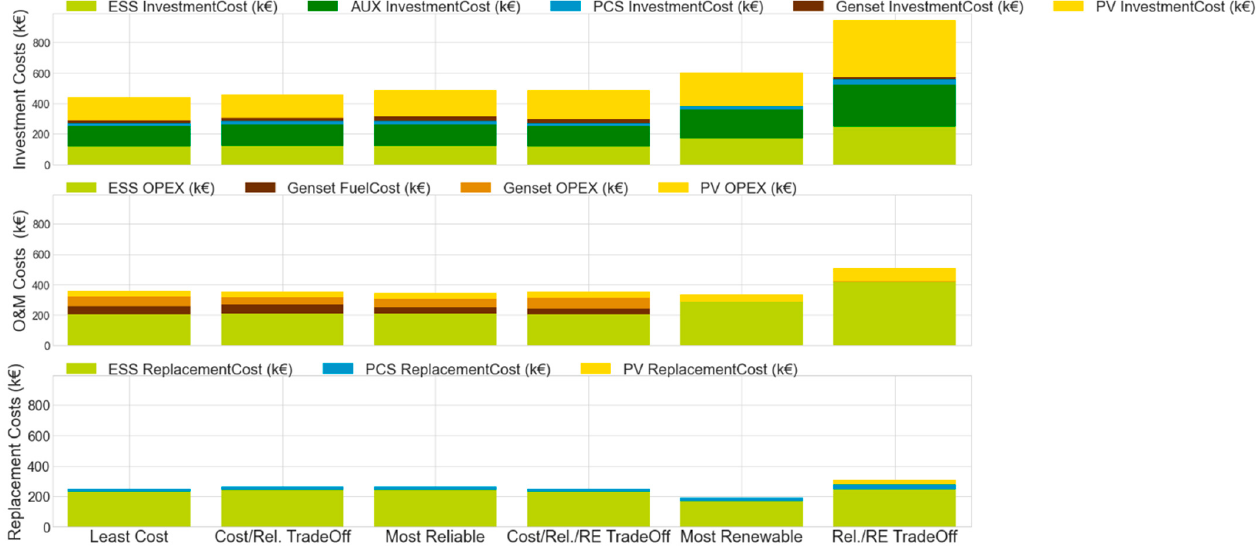
Figure 12. Cashflows for the six selected solutions.